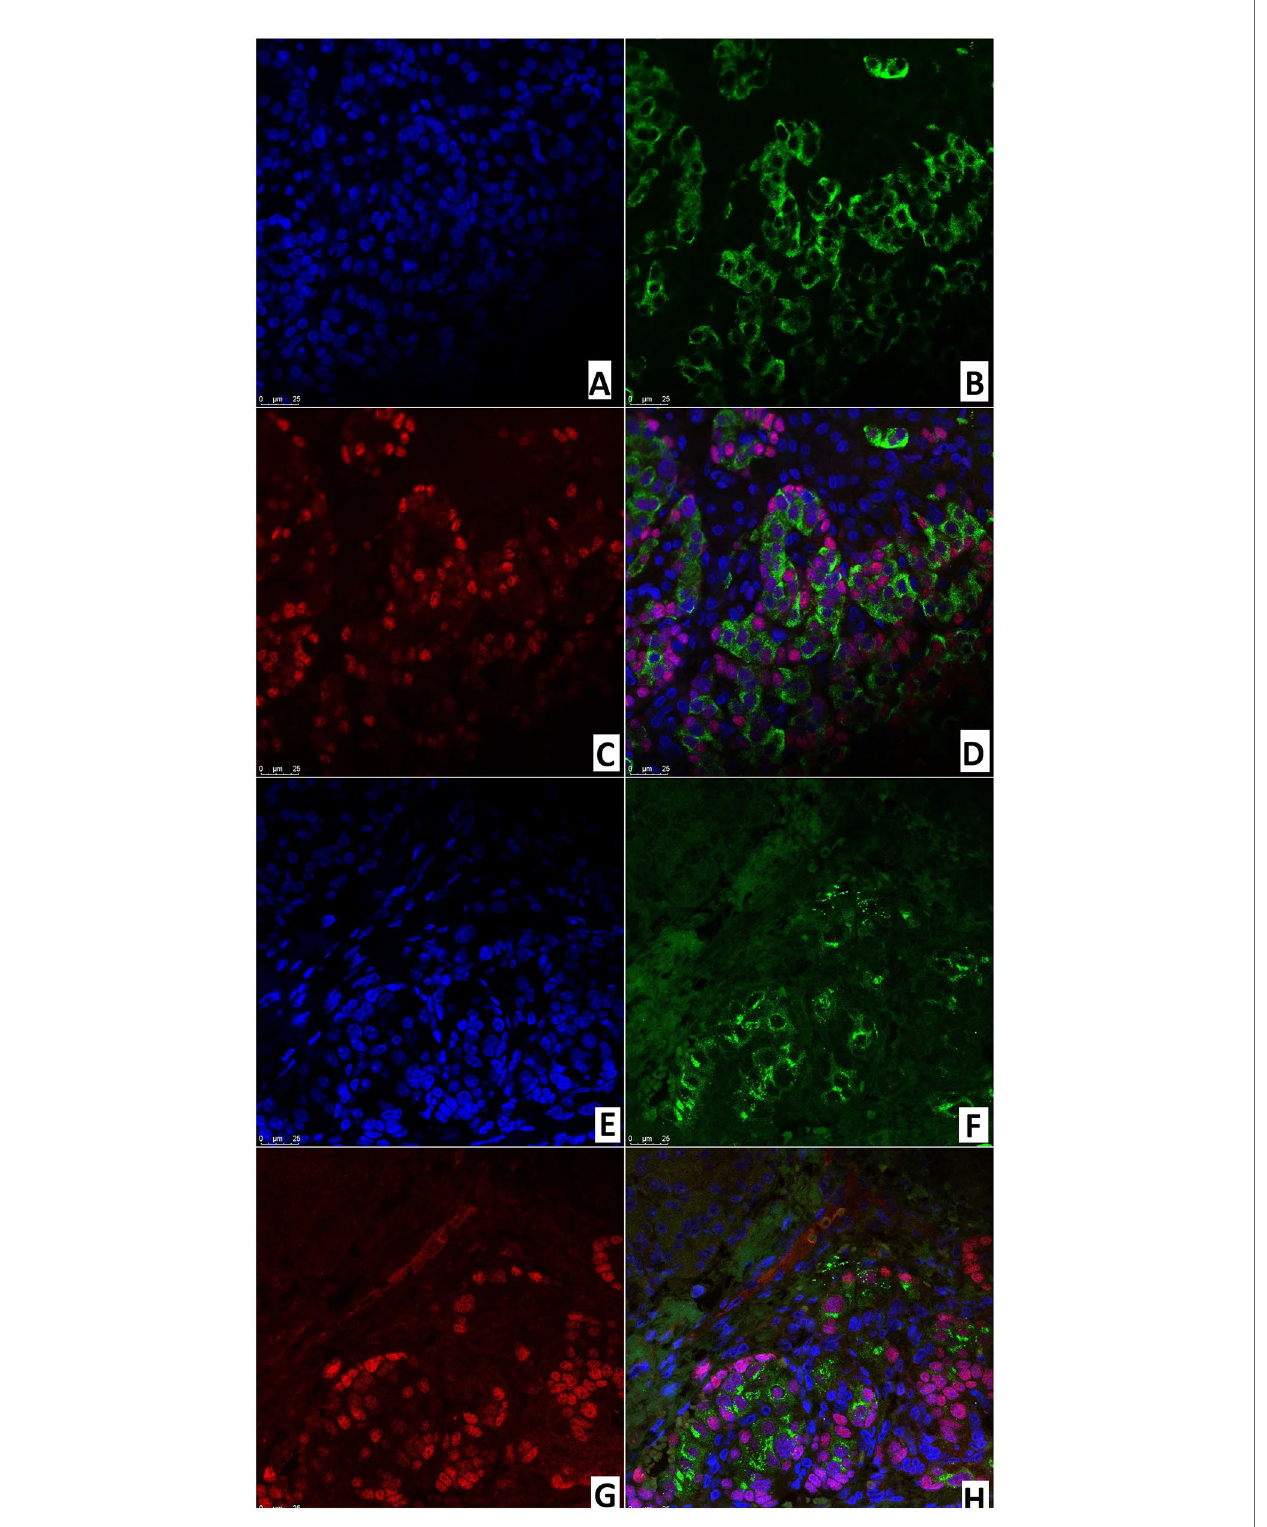
FIGURE 12 | Confocal laser scanning microscopy of the pancreas in congenital hyperinsulinism. (A – D) focal form, (E, F) diffuse form. (A, F) blue fl uorescence of cell nuclei (DAPI). (B, F) green fl uorescence of insulin in cytoplasm. (C, G) red fl uorescence of Isl1 in nuclei. (D, H) Isl1 (rose fl uorescence) of the nuclei and insulin (red fl uorescence) in the same cells;